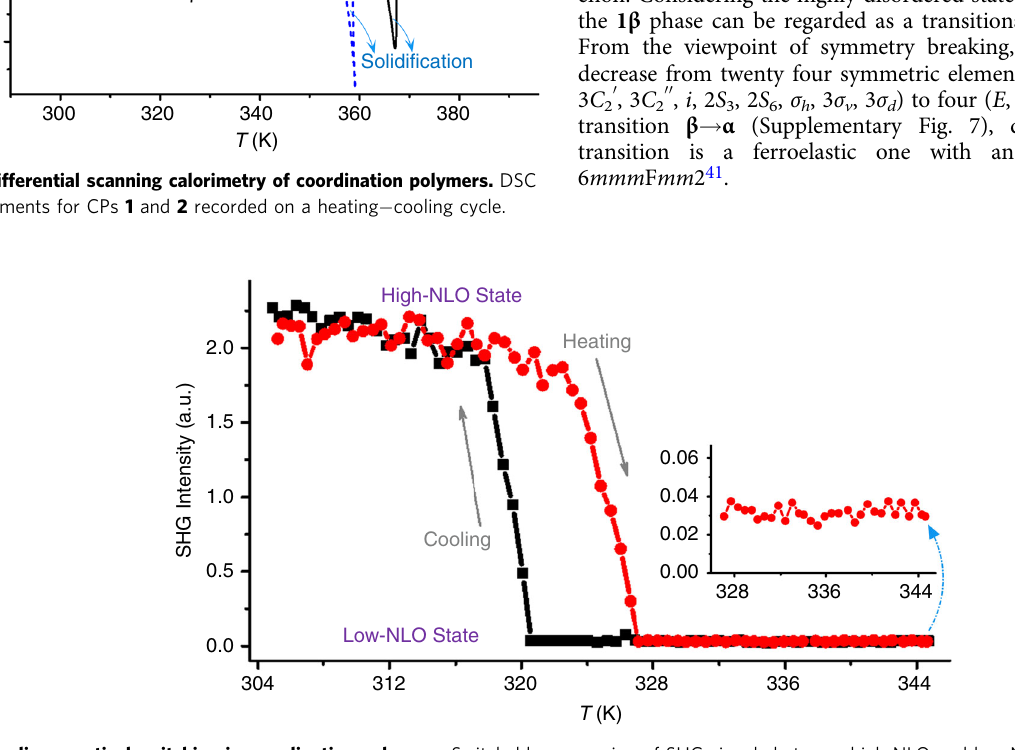
Fig. 4 Nonlinear optical switching in coordination polymers. Switchable conversion of SHG signals between high-NLO and low-NLO states of CP 1